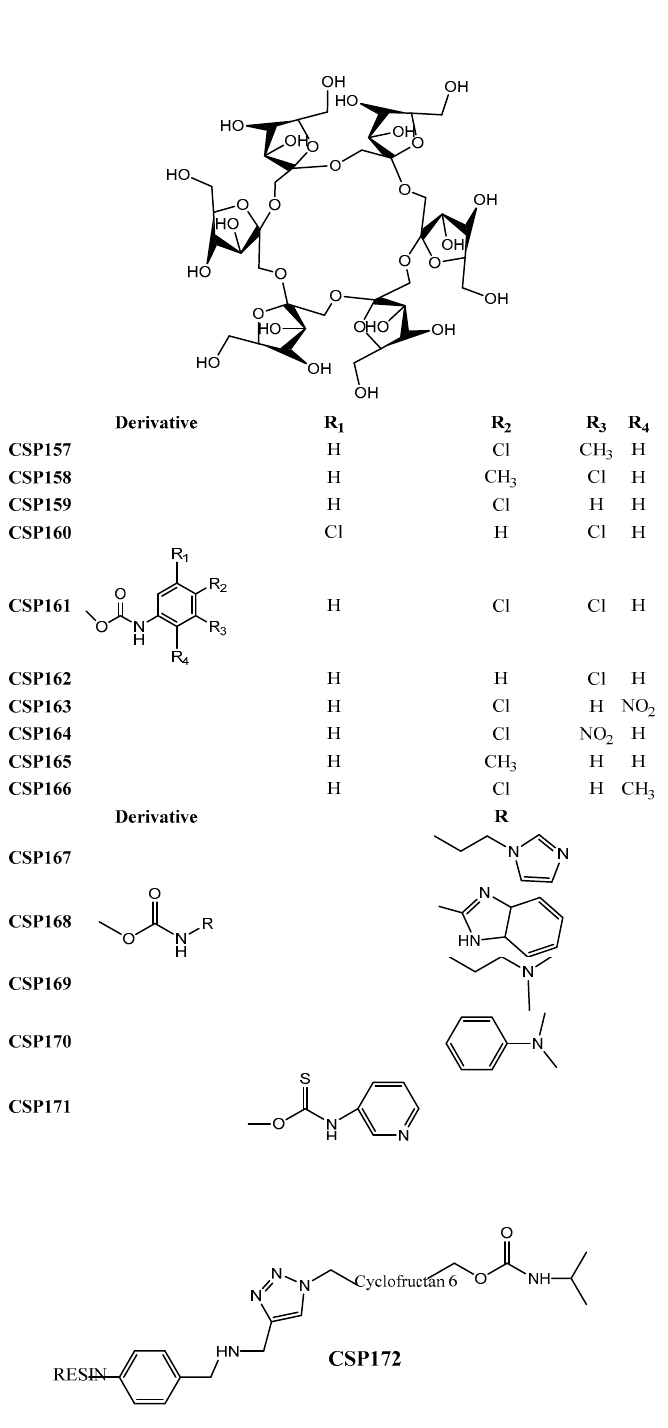
Figure 7. Chemical structures of cyclofructan-based CSP157–172.